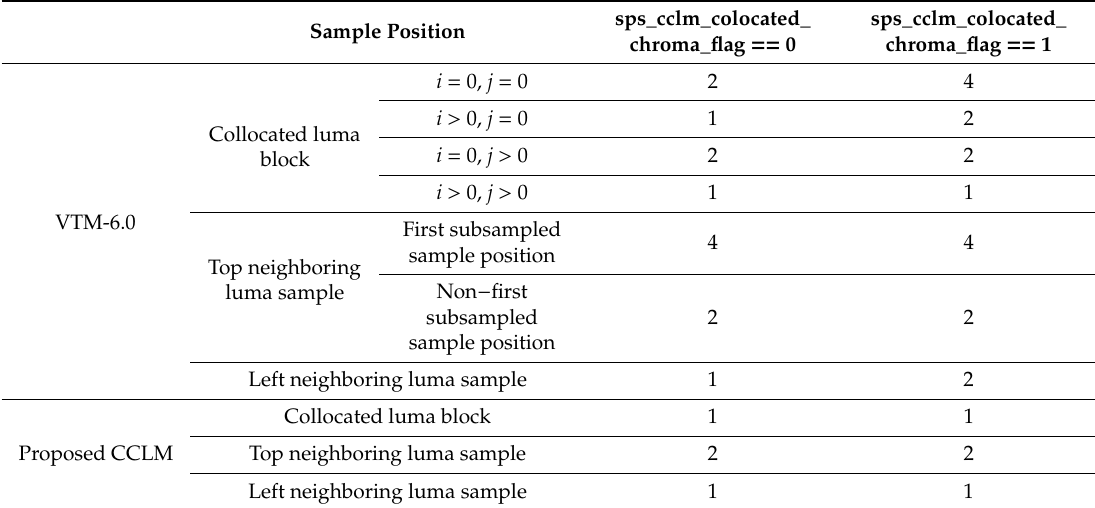
Table 4. Comparison of the number of downsampling filter shapes for the luma sample between VTM-6.0 and the proposed